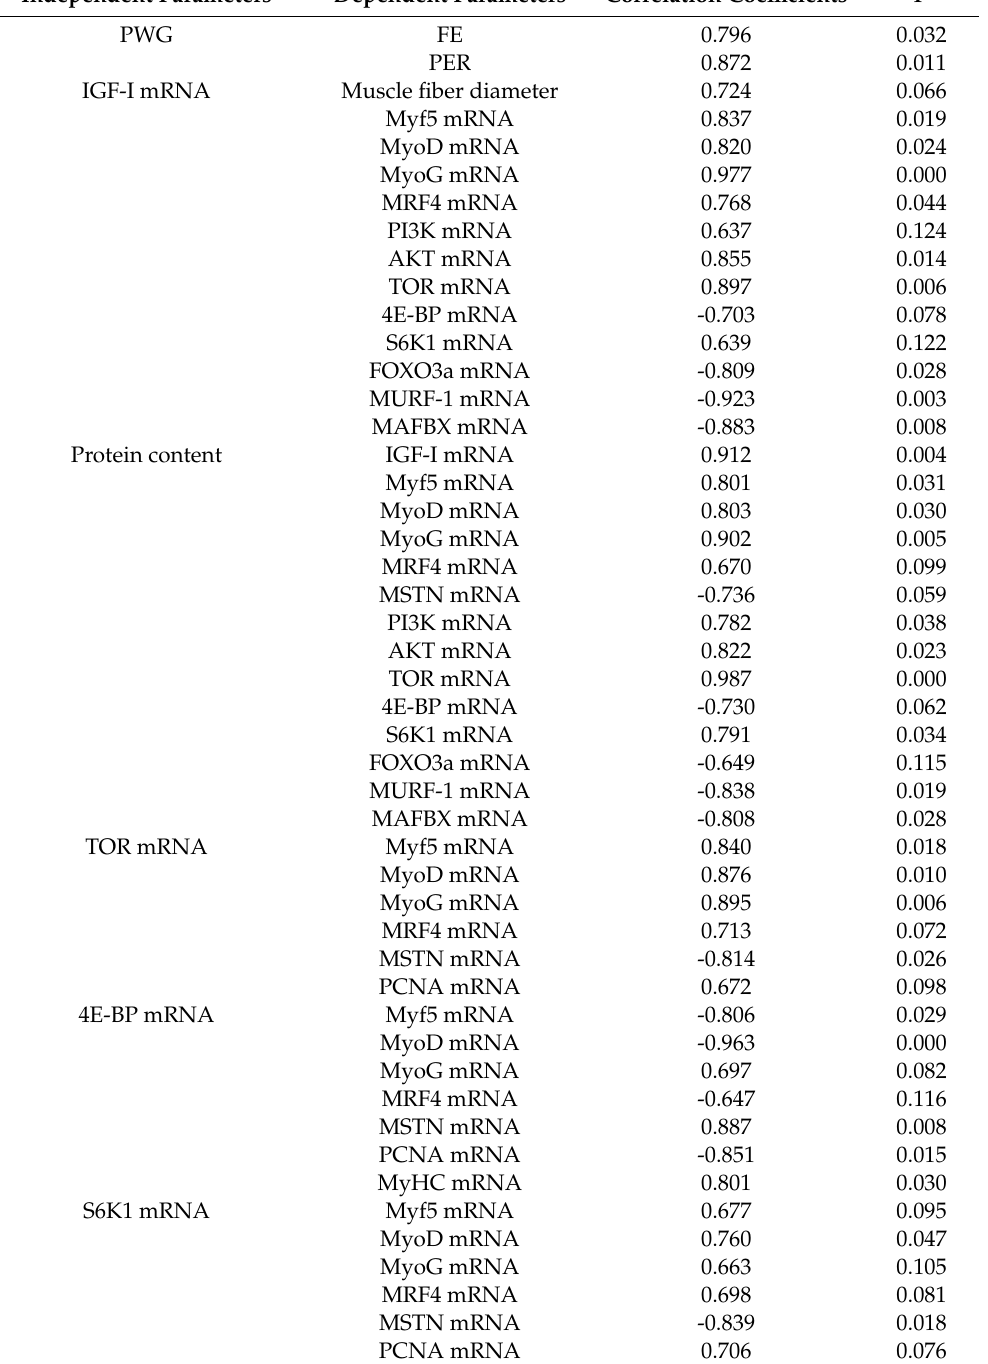
Table 6. Correlation analysis of parameters in the muscle of hybrid